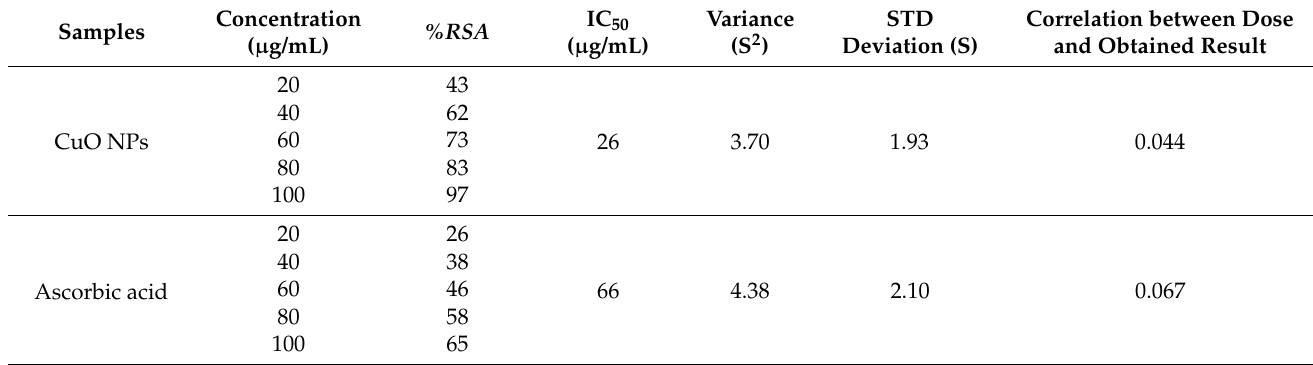
Table 2. Percent ABTS radical scavenging activity of ascorbic acid and CuO